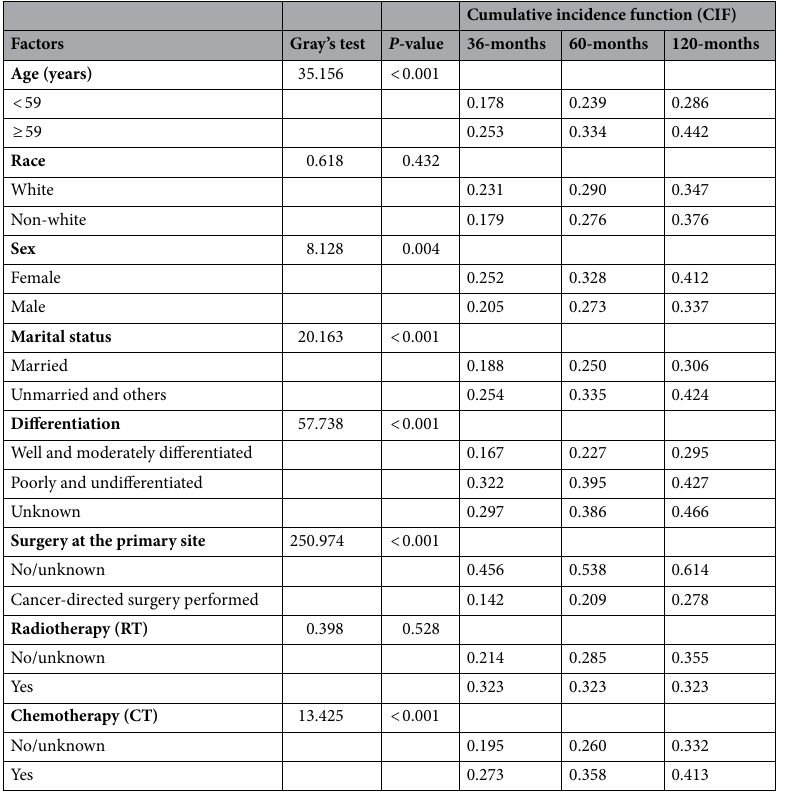
Table 2. Univariate analysis in stage Ia HCC patients by using a competing risk model.